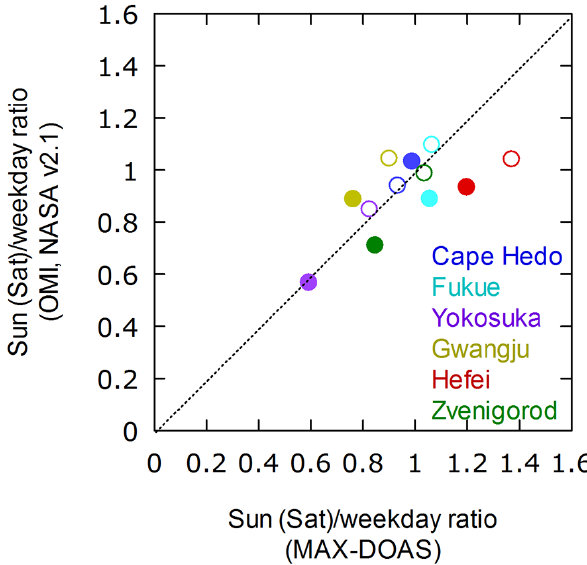
Figure 15. Diurnal variations in TropoNO2VCD separately aver- aged for days of the week. Error bars represent the 1 σ range of the included data.